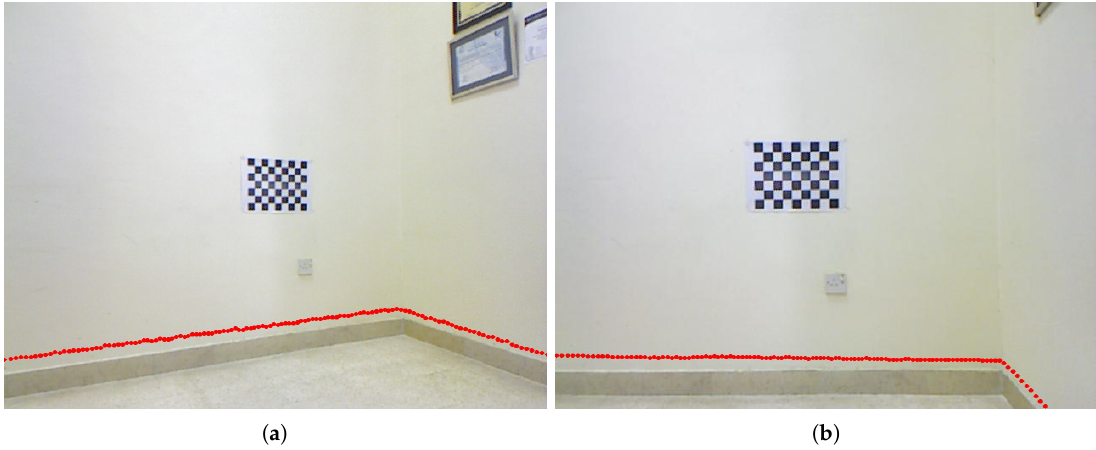
Figure 10. Configuration 3: Projection of the lidar data to two test images using the estimated Z matrix (points are shown in red color): ( a ) first test image; ( b ) second test